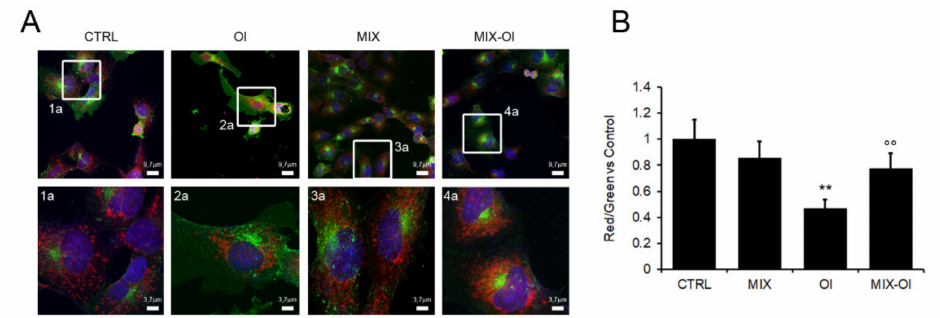
Figure 5. The MIX protects mitochondria functionality. SH-SY5Y cells were pre-treated with the 75 µ M MIX for 24 h and then exposed for further 24 h to 2.5 µ M (monomer concentration) A β 1–42 oligomers (Ol). ( A ) The cells were stained with MitoTracker CMXRos, Hoechst-33342 Nuclear stain and CTX-B Alexa488 for GM1 staining. Magnification is shown in panels. ( B ) Mitochondria functionality, as assessed by quantification of JC1 signals expressed as Red/Green ratio. Error bars refer to the standard errors of at least three independent experiments. **: p -value < 0.01 vs. untreated control cells; ◦◦ : p -value < 0.01; vs. A β 1–42 aggregates-treated cells.